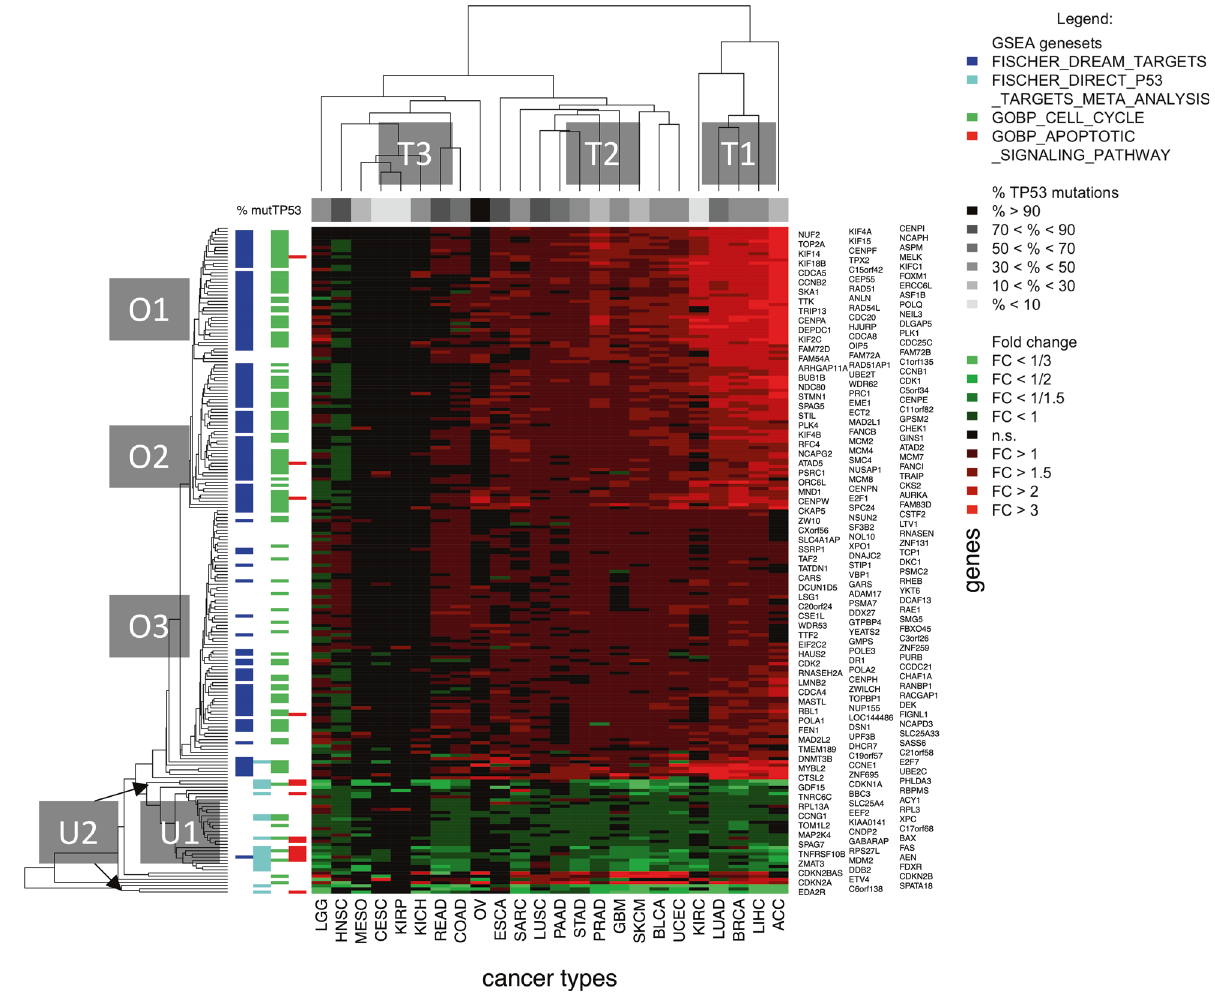
Fig. 3 Heatmap analysis of the consensus list of 210 differentially expressed genes. Genes that were signi fi cantly (raw p < 0.05) differentially expressed between TP53mut and TP53wt tumors in at least 16 of the 24 cancer types were included in the consensus list. Signi fi cant FCs (FDR = 10%) between TP53mut and TP53wt tumors are coded in red or